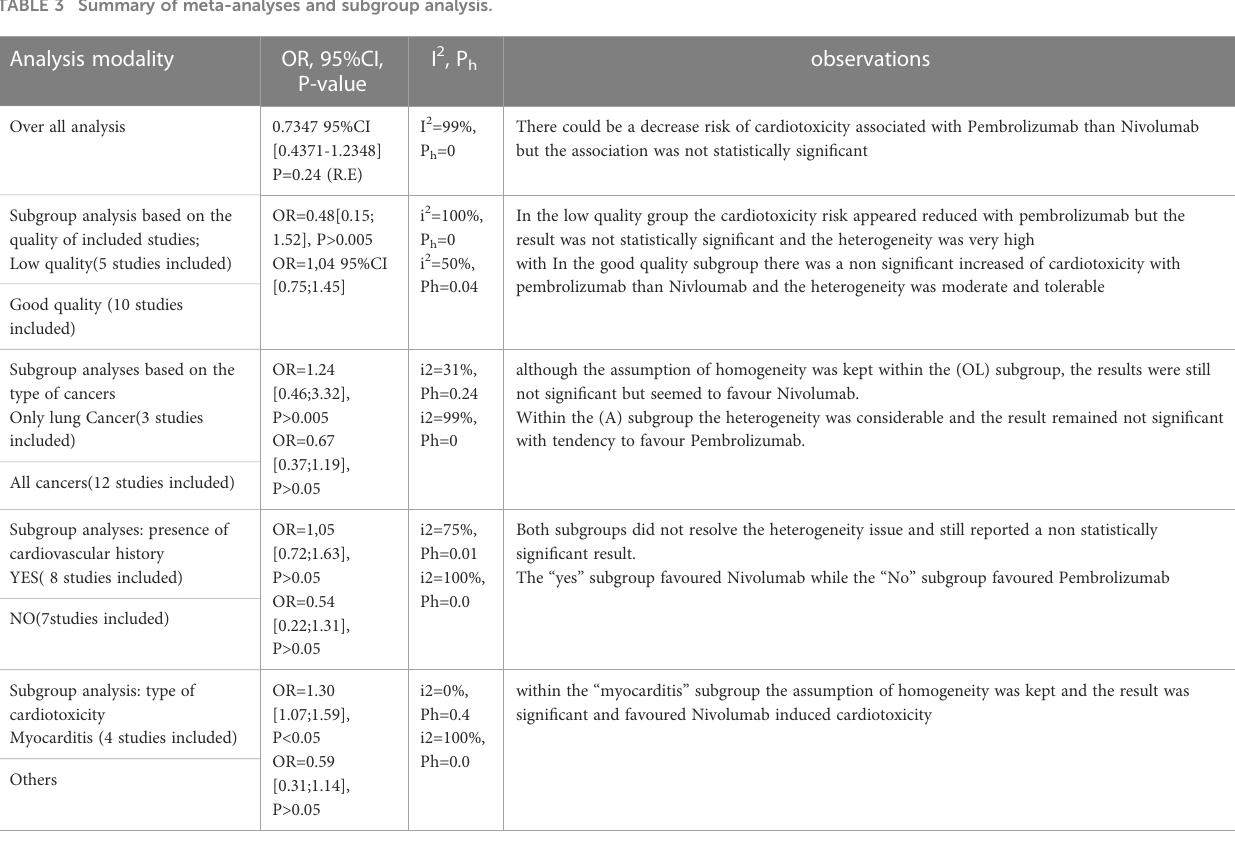
TABLE 3 Summary of meta-analyses and subgroup